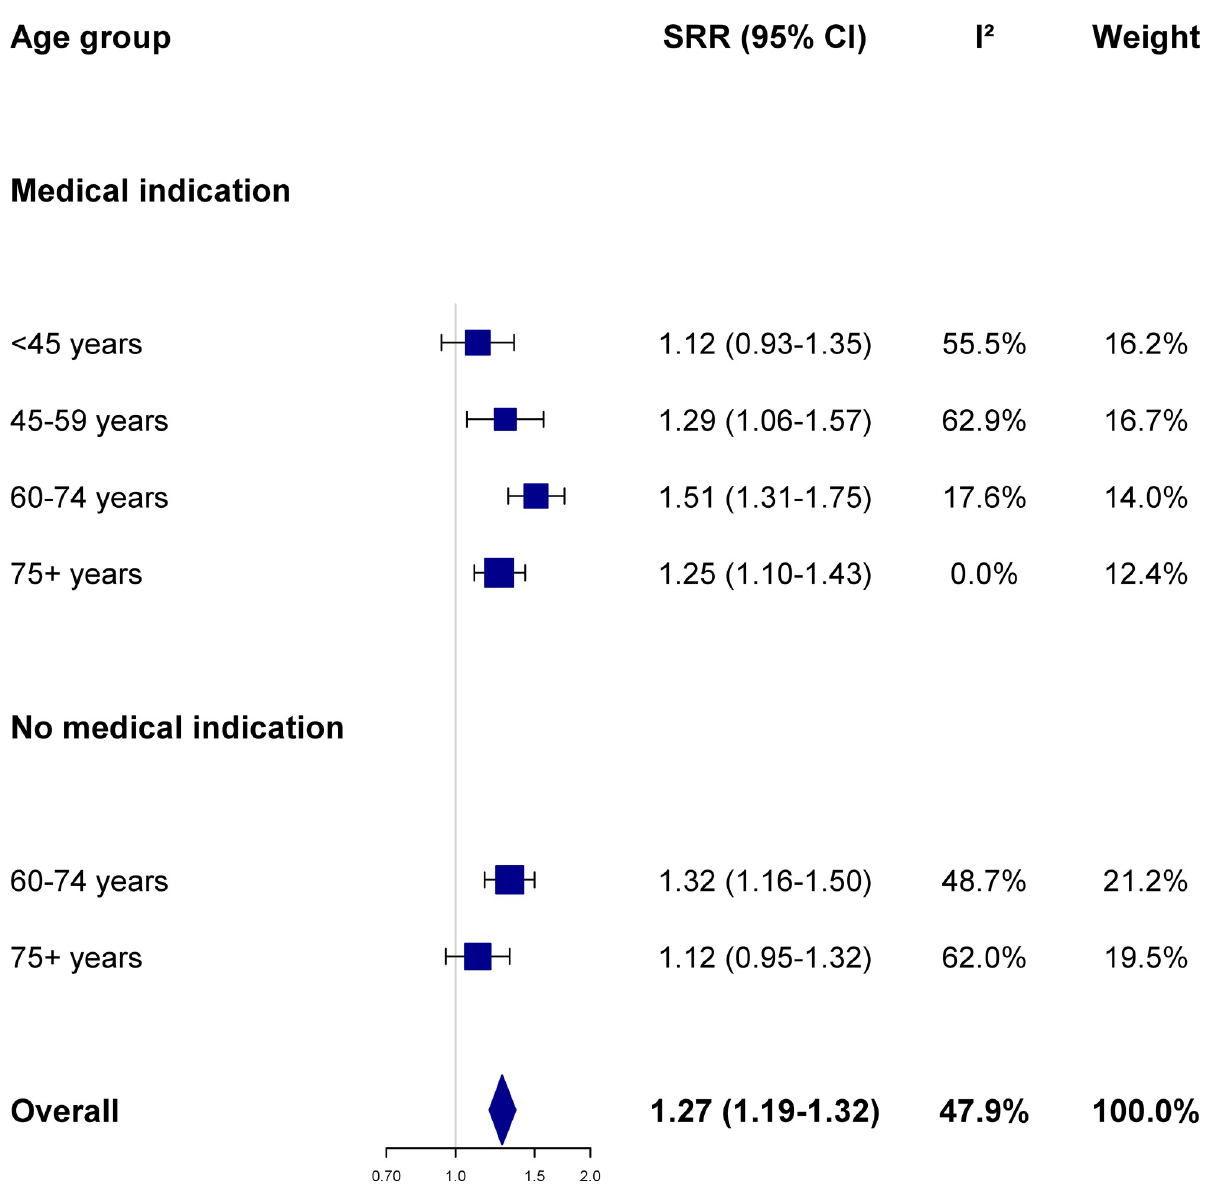
Fig 3. Association between influenza vaccination and the risk of pneumonia according to age group and presence of medical indication. Summary risk ratio (SRR) and 95% confidence intervals (CI) were calculated by pooling season-specific risk ratio using random effects meta-analysis models; between-seasons heterogeneity was quantified using the I 2 statistics (see text for details; season-specific risk ratio were provided in S3 Table). The Netherlands, seasons 2006/07 to 2015/16.